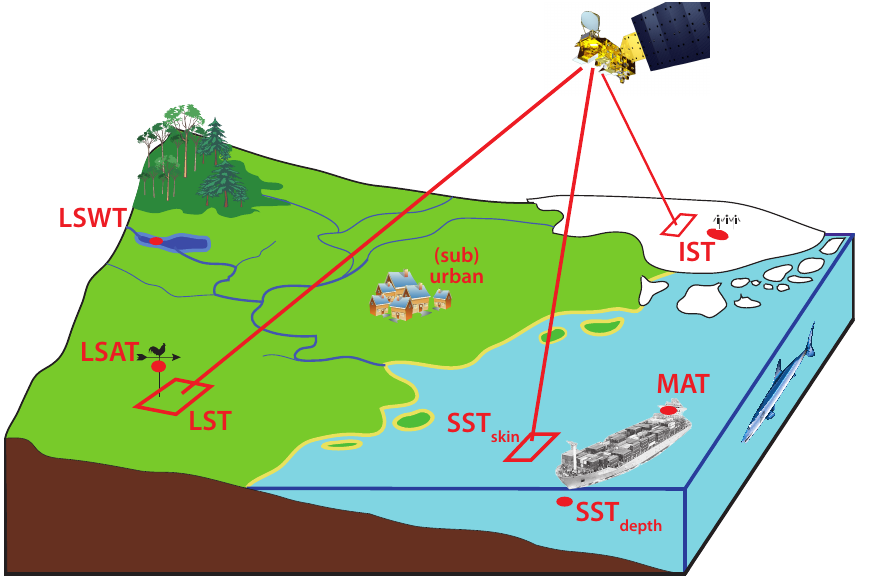
Fig. 1. Different surface temperatures discussed in this paper. SST: sea surface temperature, either at depth, measured in situ, or of the skin layer, measured by radiometers on ships or in space; MAT: marine air temperature; LST: land surface temperature, LSAT: land surface air temperature; LSWT: lake surface water temperature; IST: ice surface